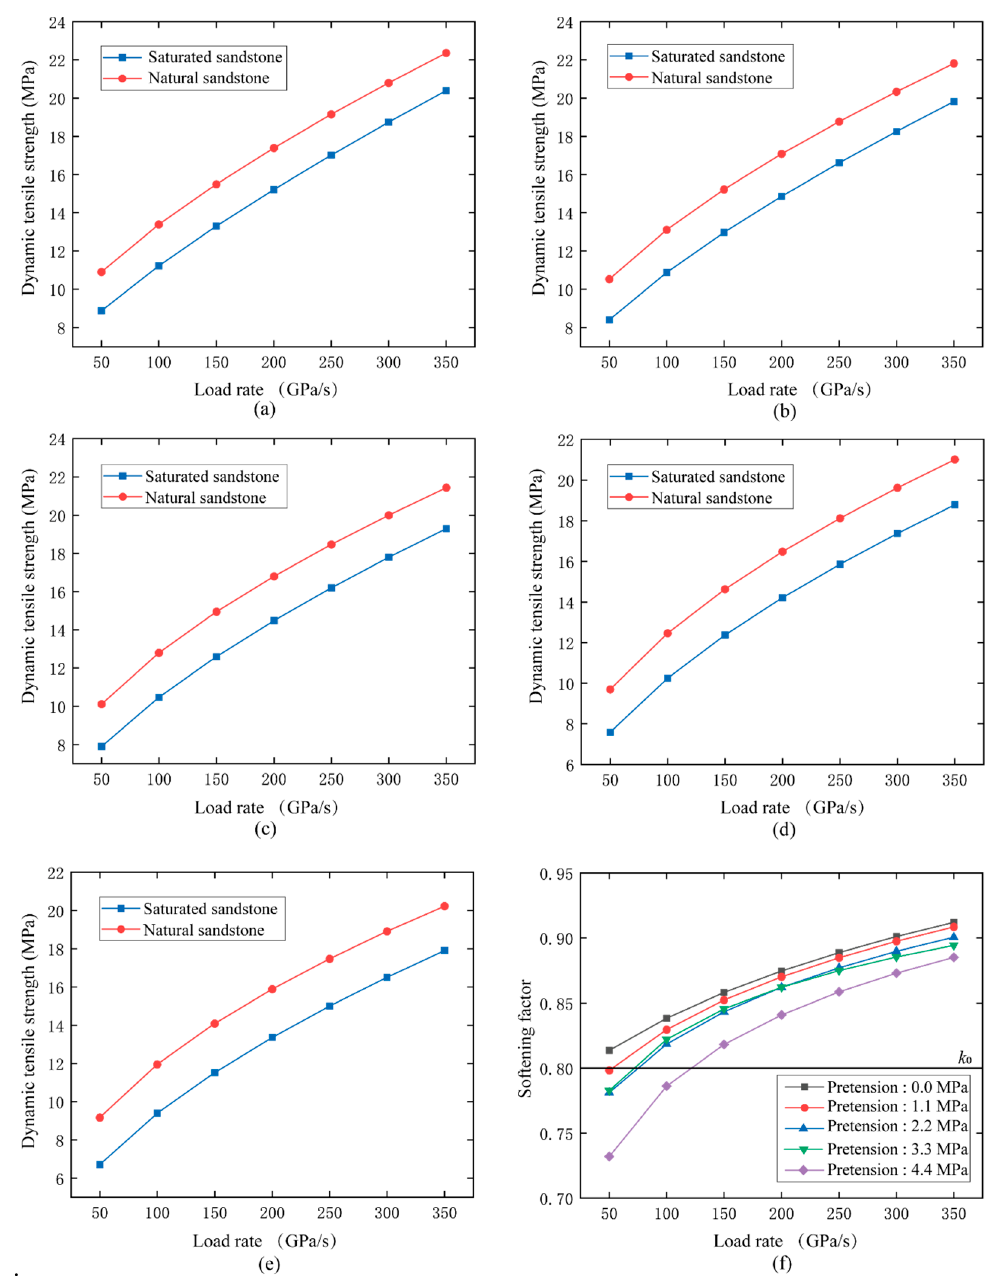
Figure 9. The variation in dynamic tensile strength versus loading rate for naturally saturated and natural sandstone under a specified static pre-tension: ( a ) 0 MPa, ( b ) 1.1 MPa, ( c ) 2.2 MPa, ( d ) 3.3 MPa for, and ( e ) 4.4 MPa. ( f ) The relationship between softening factor and loading rate under different pre-tensions.